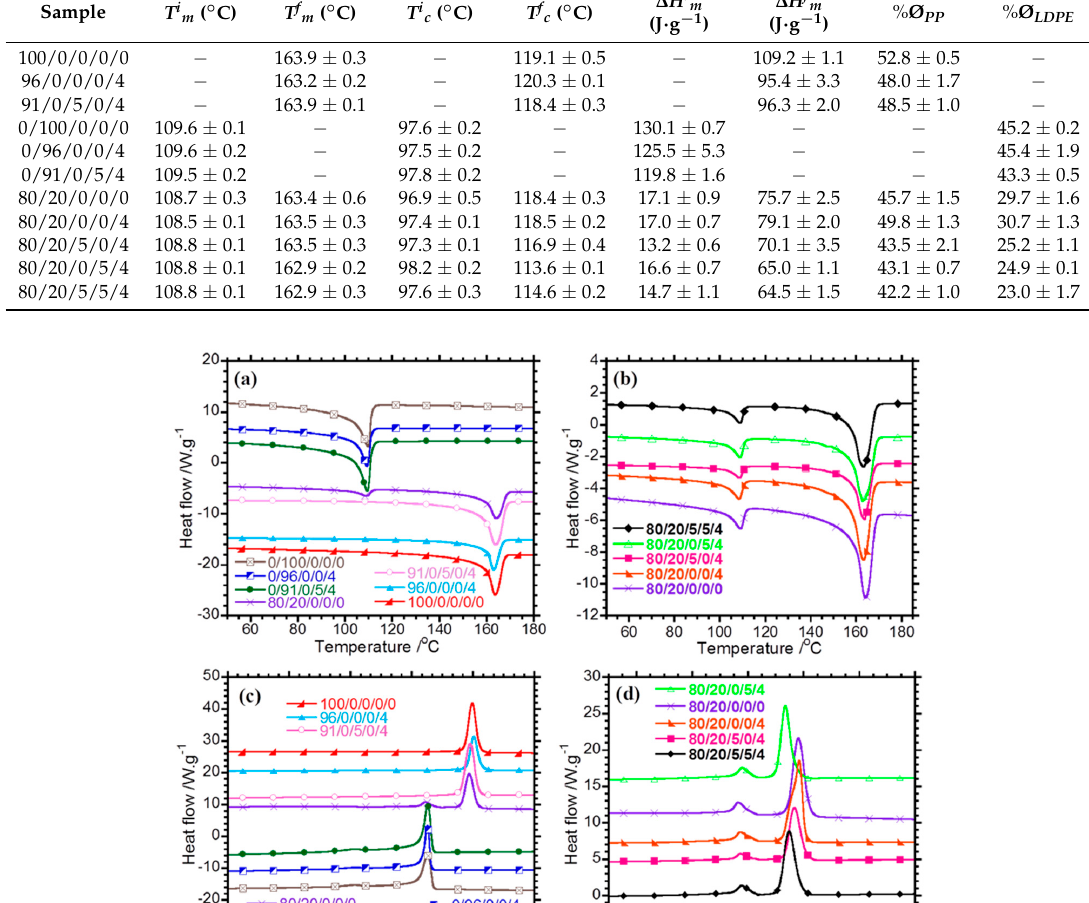
Table 2. DSC data of pristine PP, LDPE, PP/LDPE blend, and the binary and ternary composites. Sample